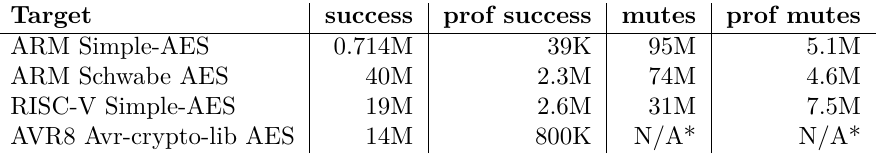
Table 5: Fault attempts needed for full key recovery, using either mutes or success, both with and without